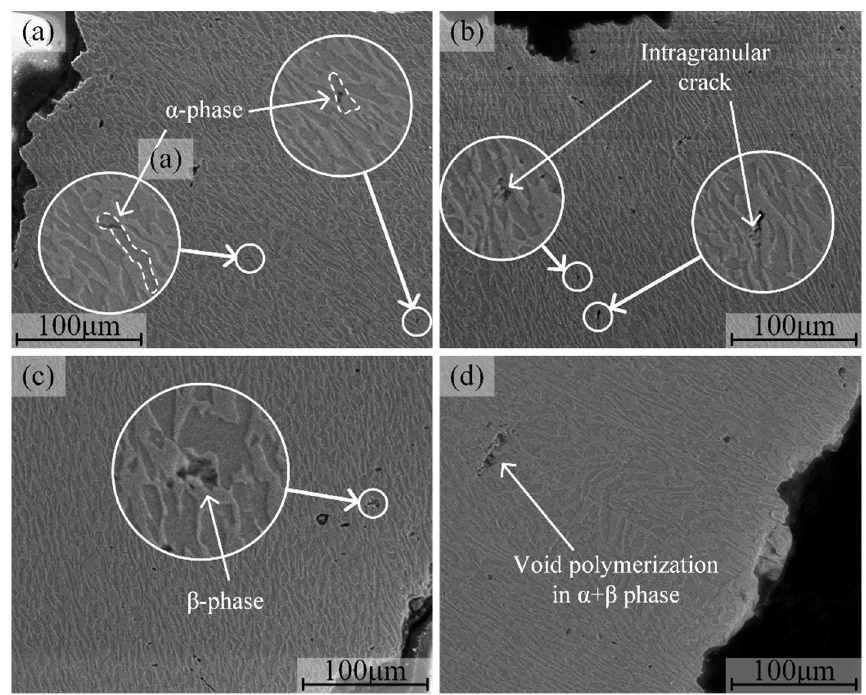
Figure 6. Tensile fracture section at different temperatures: ( a ) 20 °C; ( b ) 100 °C; ( c ) 150 °C; ( d ) 200 °C.